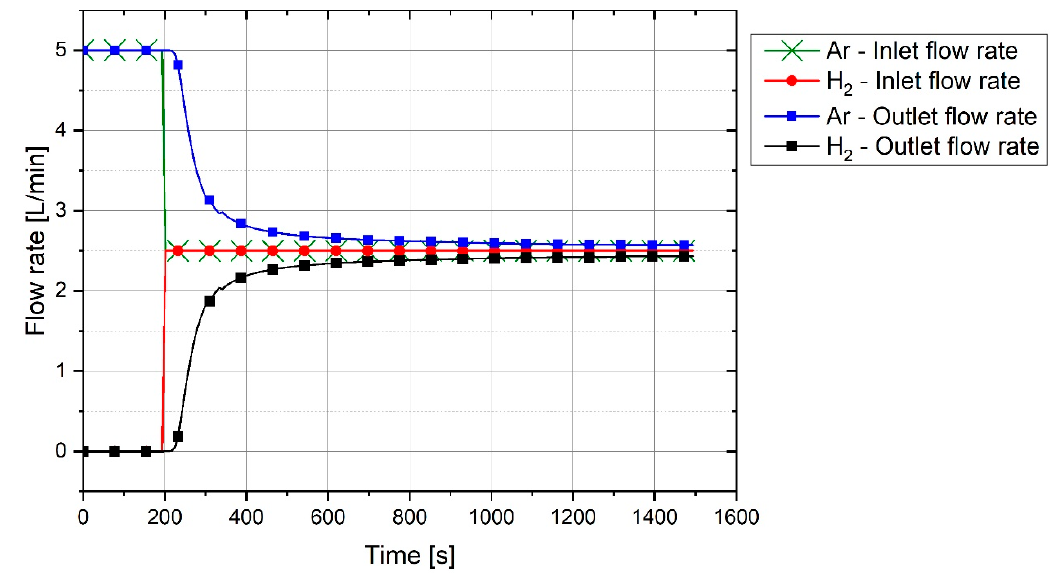
Figure 4. Reference flow rate of a premixed 50% Ar/50% H 2 gas with a total flow rate of 5 L/min.